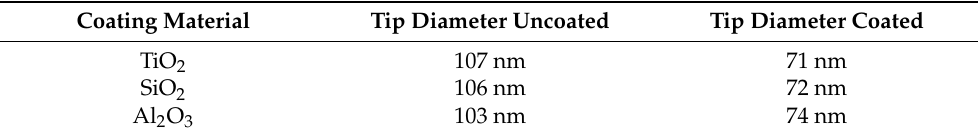
Table 1. Tip and base diameter of the single conical